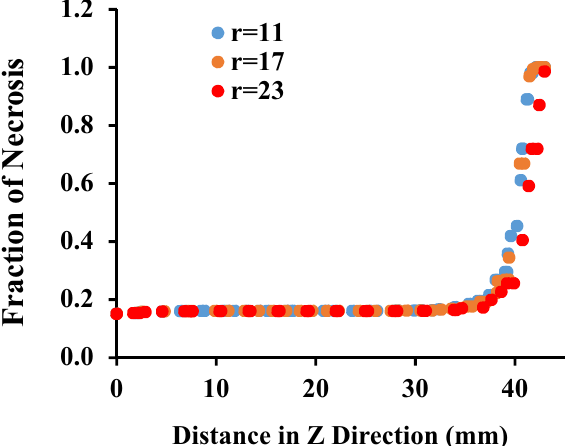
Figure 12. The fraction of tissue’s necrosis along different horizontal lines, at fixed radial distances of r = 11, 17 and 23